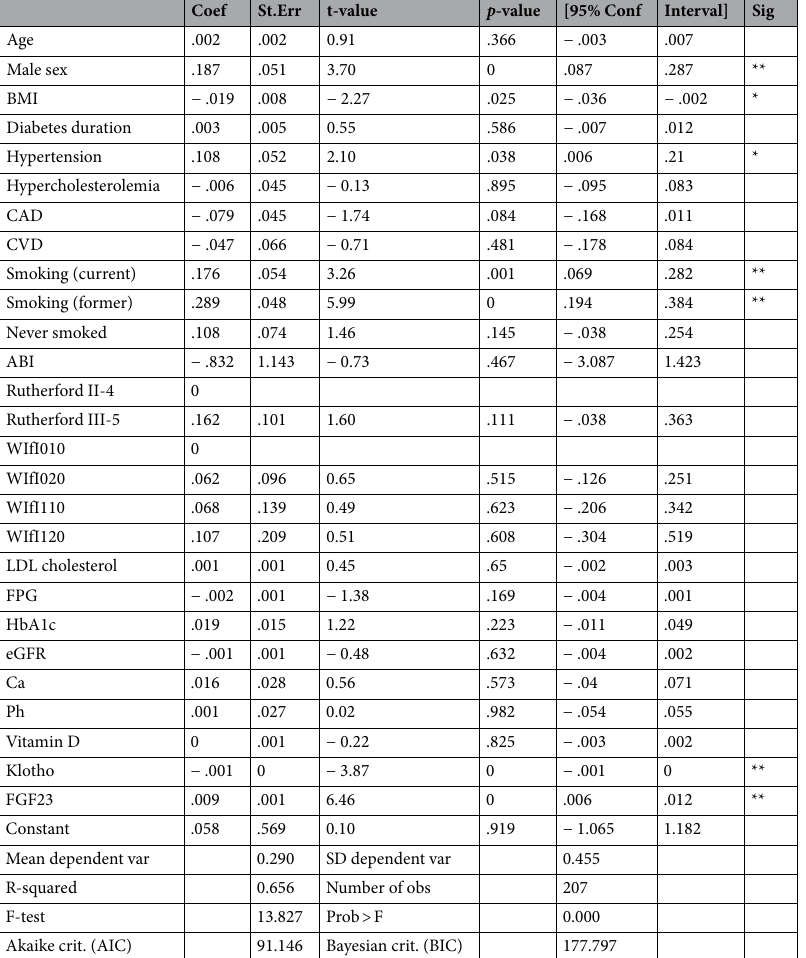
Table 3. Multivariable logistic regression for MACE. ** p < .01, * p < .05.